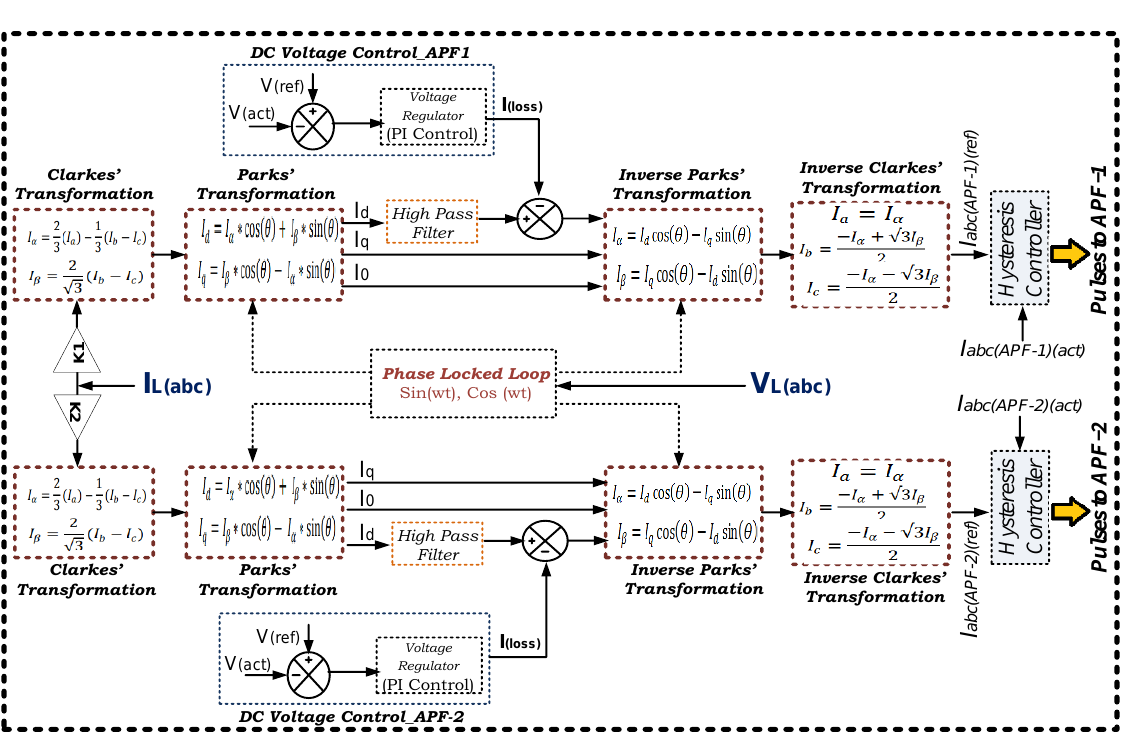
Figure 6. Modified d-q reference theory for parallel